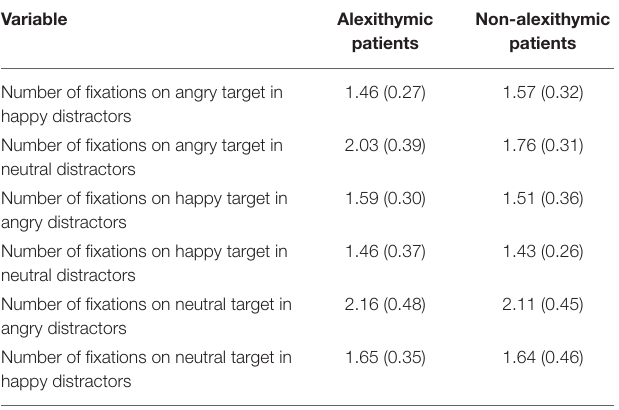
TABLE 4 | Number of fixations on target as a function of alexithymia and emotional quality of target and distractor face [means and SD (in brackets)]. Variable